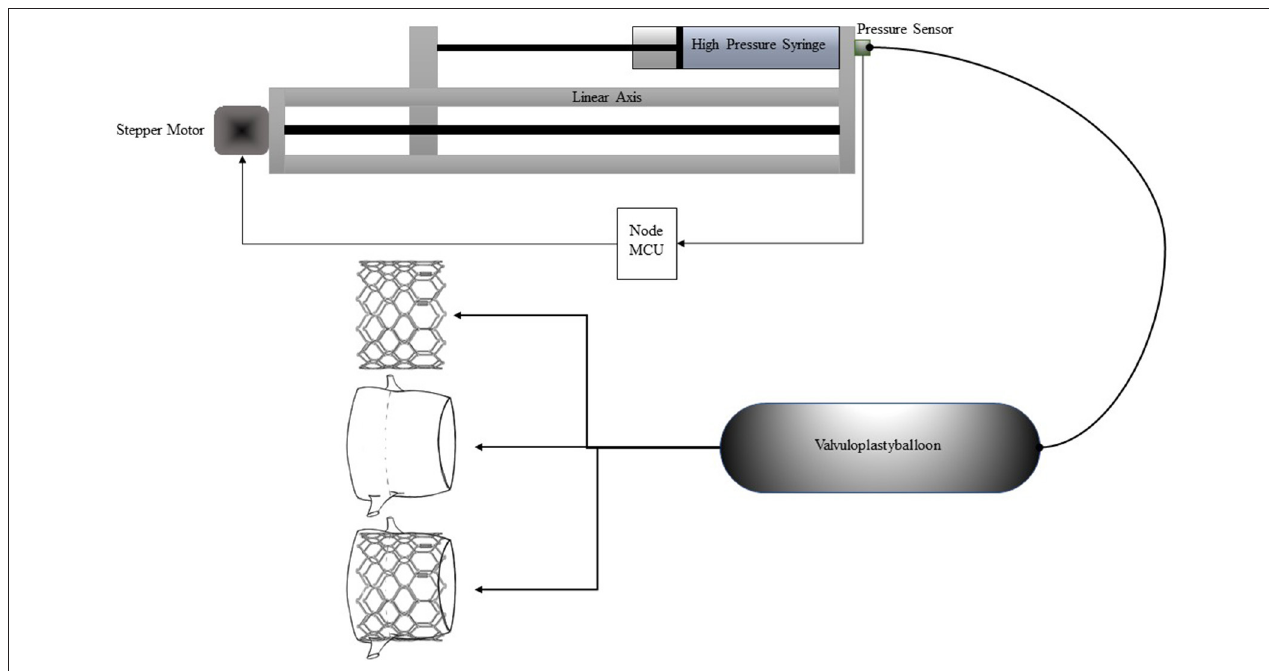
FIGURE 1 | Schematic representation of the setup.